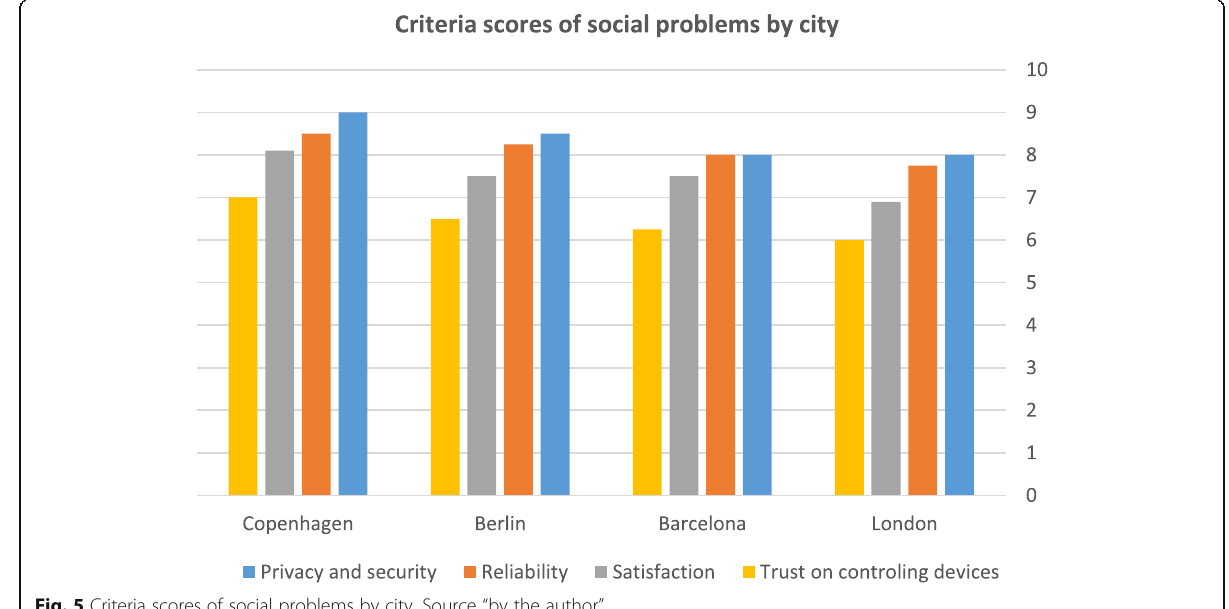
Fig. 5 Criteria scores of social problems by city. Source “ by the author ”